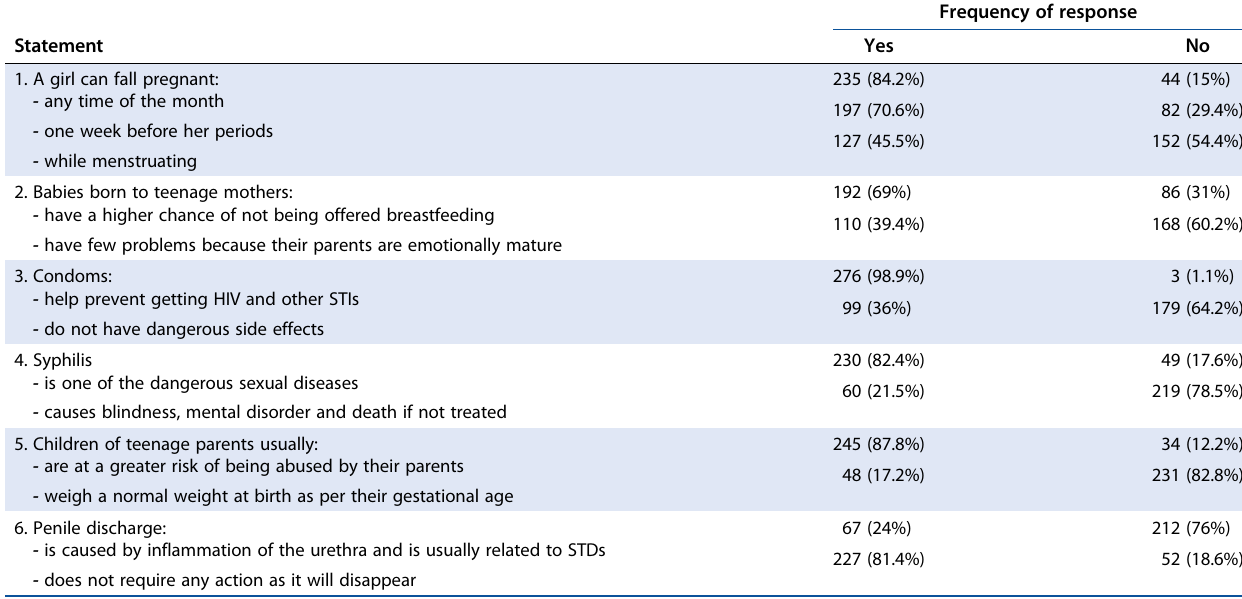
Table 2: Knowledge responses on different aspects of sexual and reproductive health